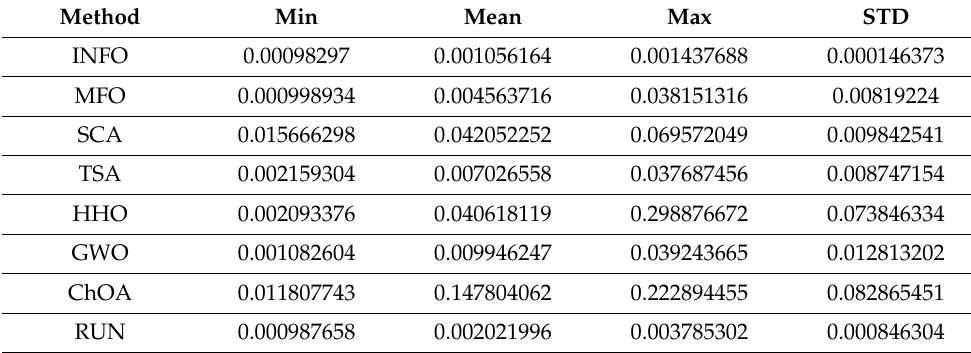
Table 8. Statistical results for the